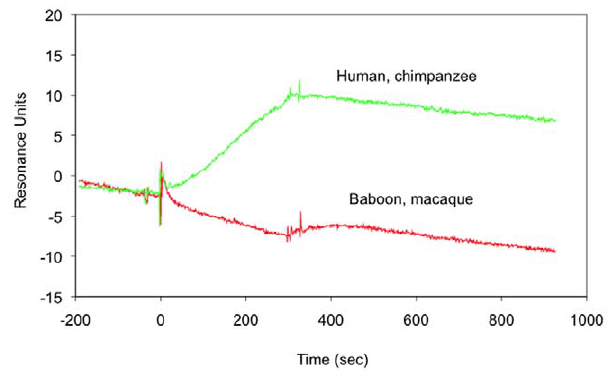
Figure 5. BIACORE H sensogram of interactions between MAb DB81 (bound to the chip) and peptides GTWTCTVLQNQKKVEF- KID (human, shown as a green line) or peptide GTWT- CTVSQDQKTVEFKID (baboon, shown as a red line). The peptides correspond to aa. 180-198 of membrane CD4 from Hominidae (e.g., Homo and P. troglogites ) and Cercopithecidae (e.g., Macaca ), respectively.